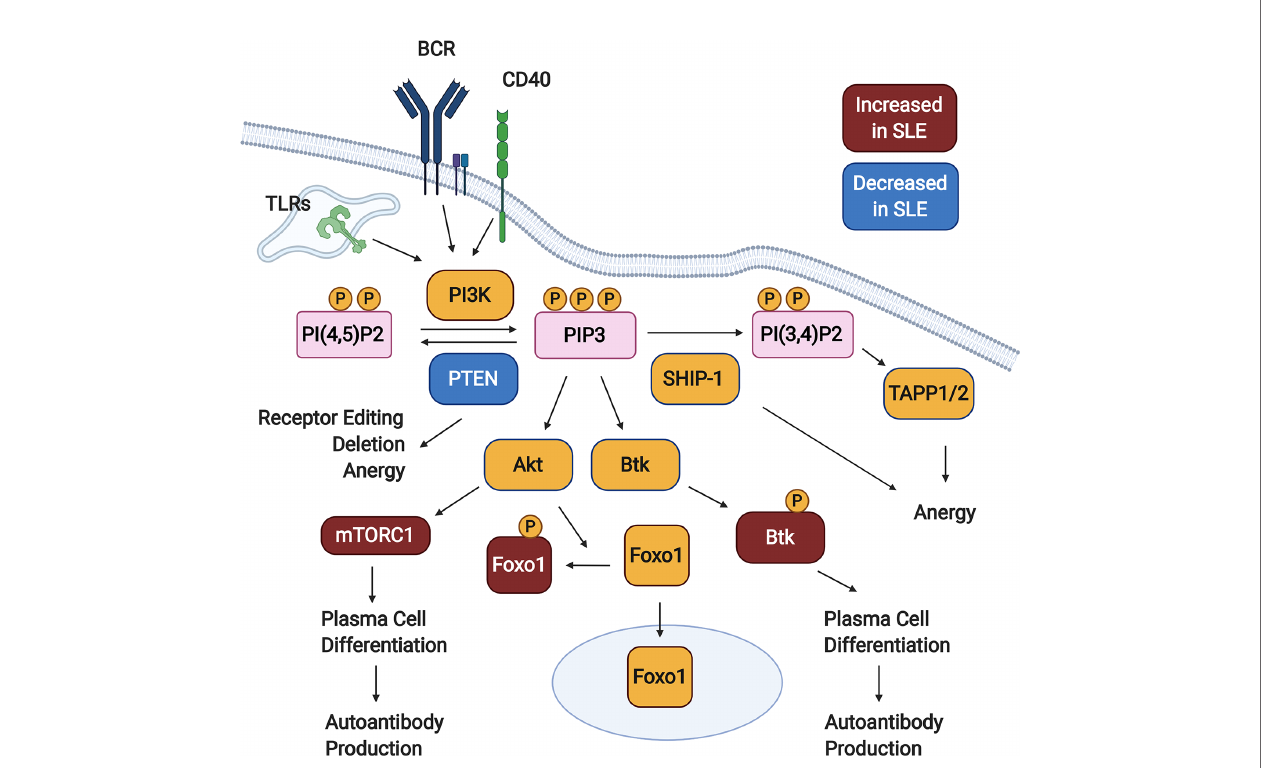
FIGURE 1 | PI3K signaling promotes loss of B cell tolerance. In response to activating signals, PI(4,5)P2 is phosphorylated by PI3K, generating PIP3. Downstream of PIP3, various signaling pathways are activated (not all shown), including those mediated by Akt and Btk. PI3K signaling is kept in check by the inositol phosphatases SHIP-1 and PTEN, which dephosphorylate PIP3 to form PI(3,4)P2 and PI(4,5)P2, respectively. Studies in animal models demonstrate that PTEN promotes both central and peripheral B cell tolerance checkpoints, while SHIP-1 plays a predominant role in maintaining anergy. B cells from Systemic Lupus Erythematosus (SLE) patients demonstrate some defects indicative of elevated PI3K signaling, including reduced PTEN expression, increased cytoplasmic Foxo1, increased mTORC1 activation, and increased phosphorylation of Btk. Created with